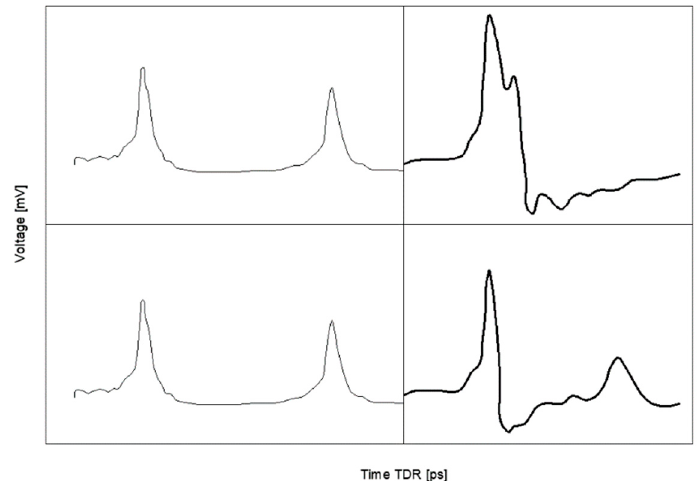
Figure 2. Example of TDR waveforms for dry ( top ) and moist ( bottom ) material acquired from an ETest LP/ms TDR probe (own elaboration based on calibration tests). Left-hand side—control peaks, right-hand side—measuring peaks.